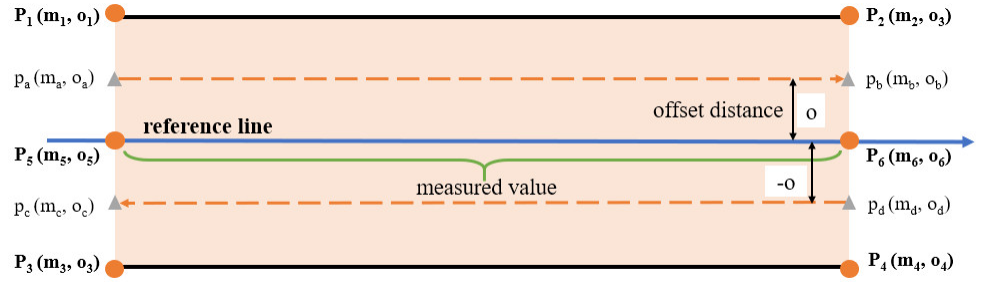
Figure 7. Diagram of lane line